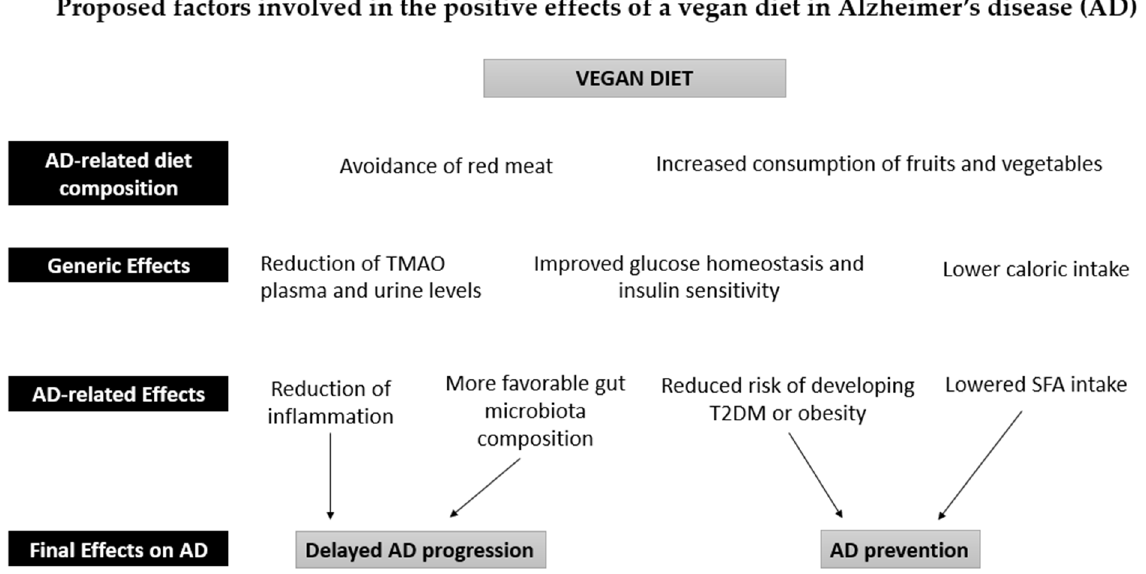
Figure 1. Proposed factors involved in the positive effects of a vegan diet in Alzheimer’s disease (AD). The intake of fruits and vegetables in a vegan diet is associated with a reduction in inflammatory processes and a normalization of the gut microbiota due to the high antioxidant, fiber, and polyphenol content. The absence of red meat also leads to a reduction in Trimethylamine N-Oxide (TMAO) in plasma and urine. These effects can counteract the development of AD pathology. Furthermore, the reduction in caloric intake reduces the risk of obesity and type 2 diabetes (T2DM), thus contributing to the prevention of AD, together with the reduced intake of saturated fatty acids (SFA).